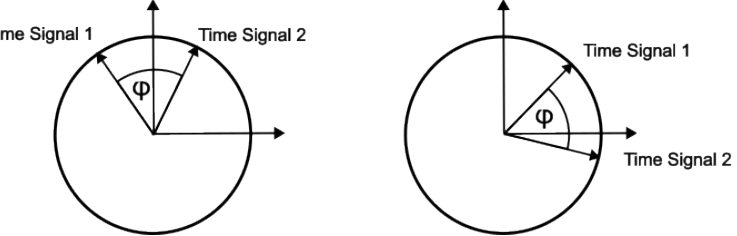
Figure 1. A sketch demonstrating two time signals in the pointer representation: the instantaneous time varies, whereas the relative phase position, and hence, the oscillation phase difference, is the